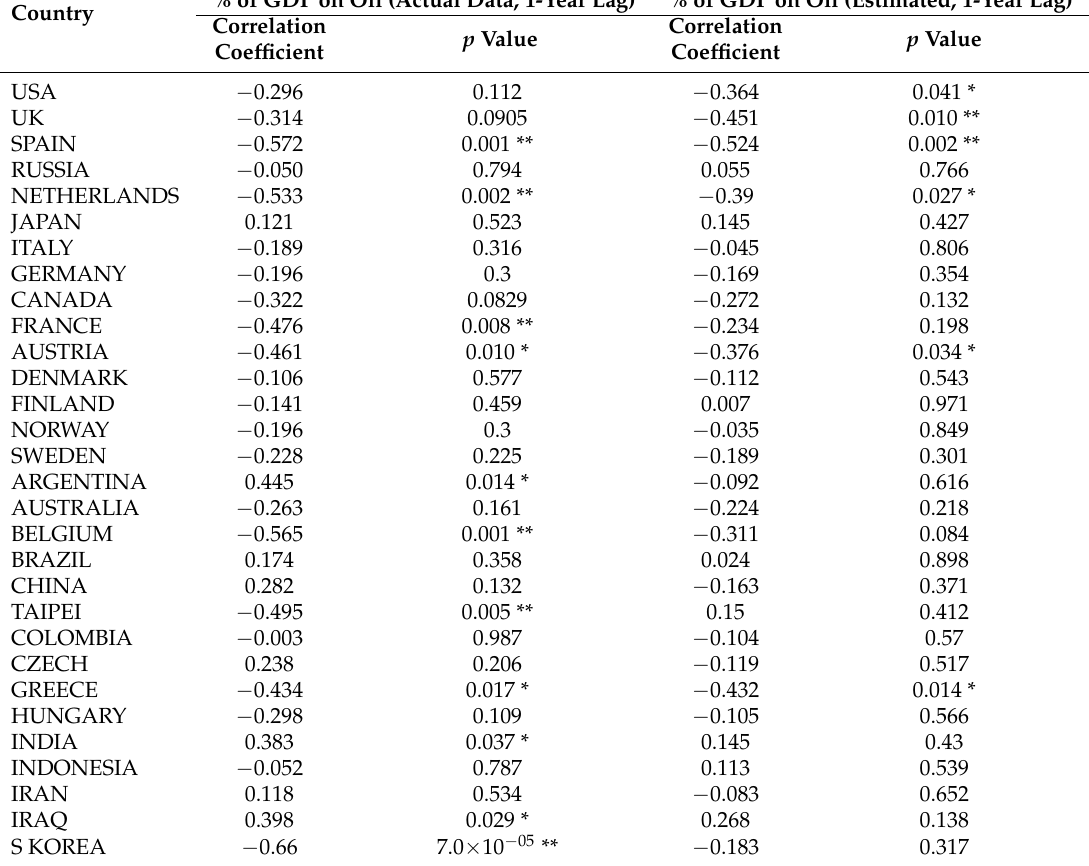
Table 3. The correlation of the ratio of GDP for oil only energy expenditures, both Actual Data expenditures using available data and Estimated expenditures when substituting missing price data, to the 1-year lagged annual change in GDP shows less negative correlation to individual countries and the world overall than to the ratio of all energy expenditures to GDP (see Table 1). * = p value < 0.05; ** = p value < 0.01. The countries in this table account for approximately 93% − 95% of world